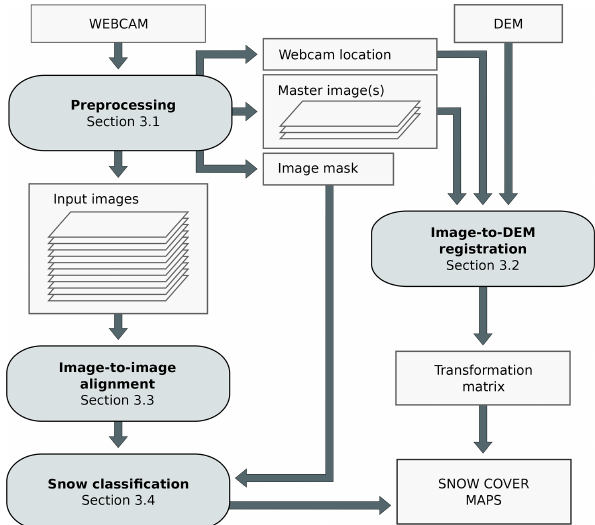
Figure 3. Overview of the proposed procedure. It consists of four major steps: preprocessing, automatic image-to-DEM registration, automatic image-to-image alignment, and automatic snow classifi- cation. Image-to-DEM registration results in a transformation ma- trix that is used to project the snow-classified pixels onto a